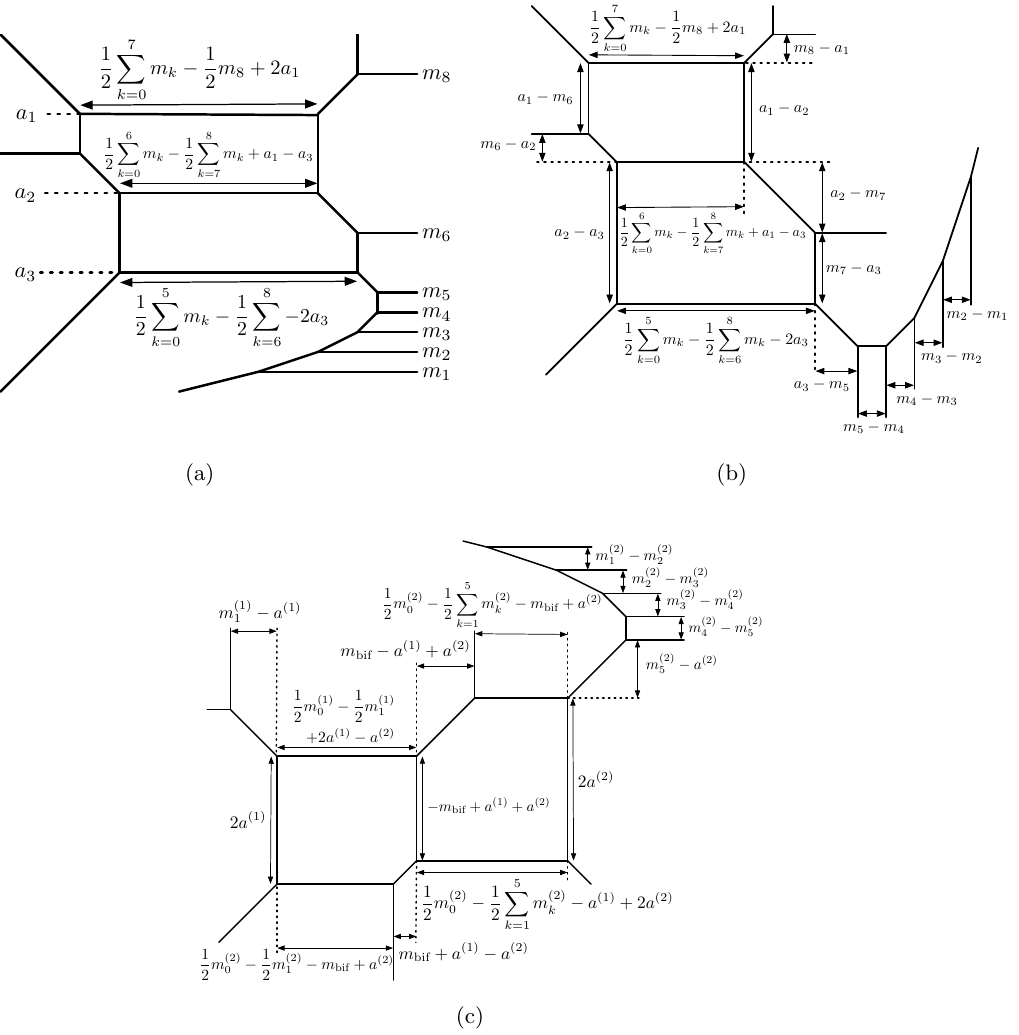
Figure 13 . (a). 5-brane web for 5d = 1 SU(3) gauge theory with Chern-Simons level 2 and N with N f = 8 (cid:13)avors. (b). 5-brane web after sequence of Hanany-Witten transition. (c). 5-brane web for 5d = 1 SU(2) quiver gauge N